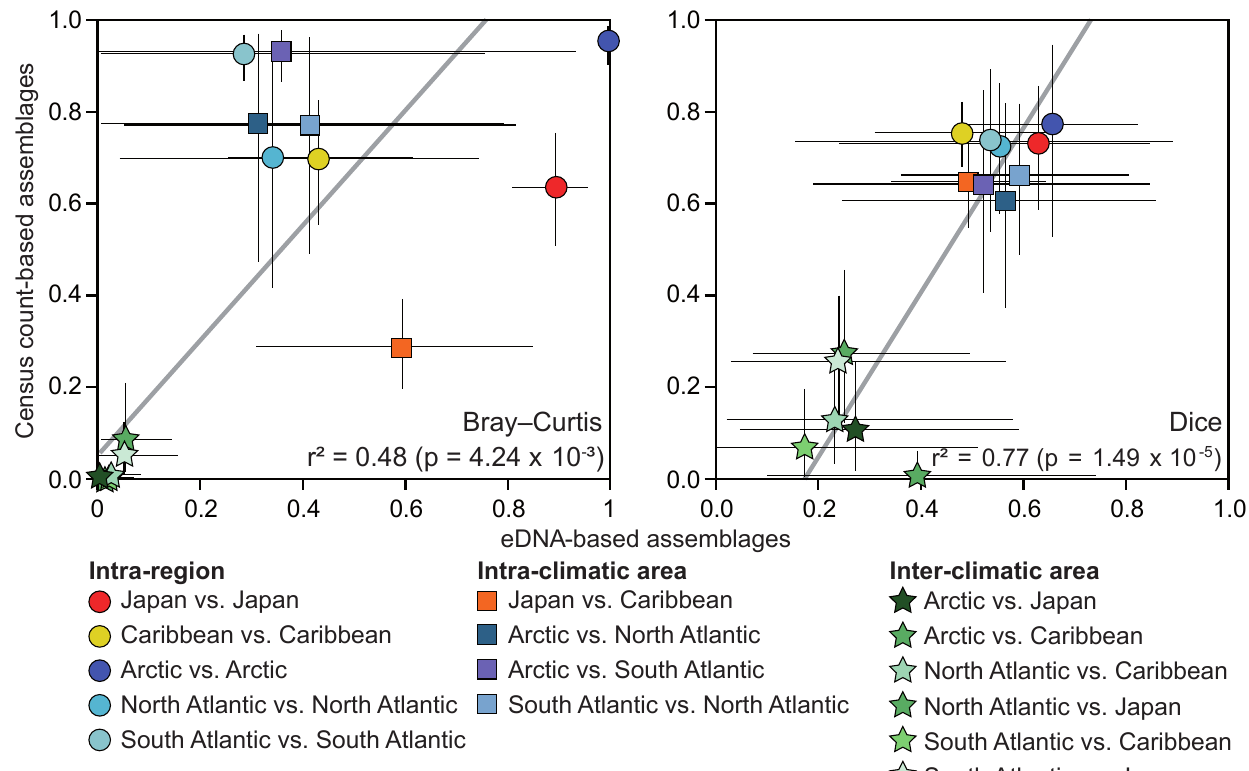
Figure 6. e DNA vs. census counts. Similarity pairwise comparison of the community composition inferred from relative abundances of morphospecies based on e DNA and census counts among and between the five sampled regions based on the Bray–Curtis and Dice indices. Each symbol corresponds to the average between all pairwise distances of each category and the lines represent the standard deviation. The grey lines represent the linear regression, with r 2 and p values provided in the right bottom corner of each graph.